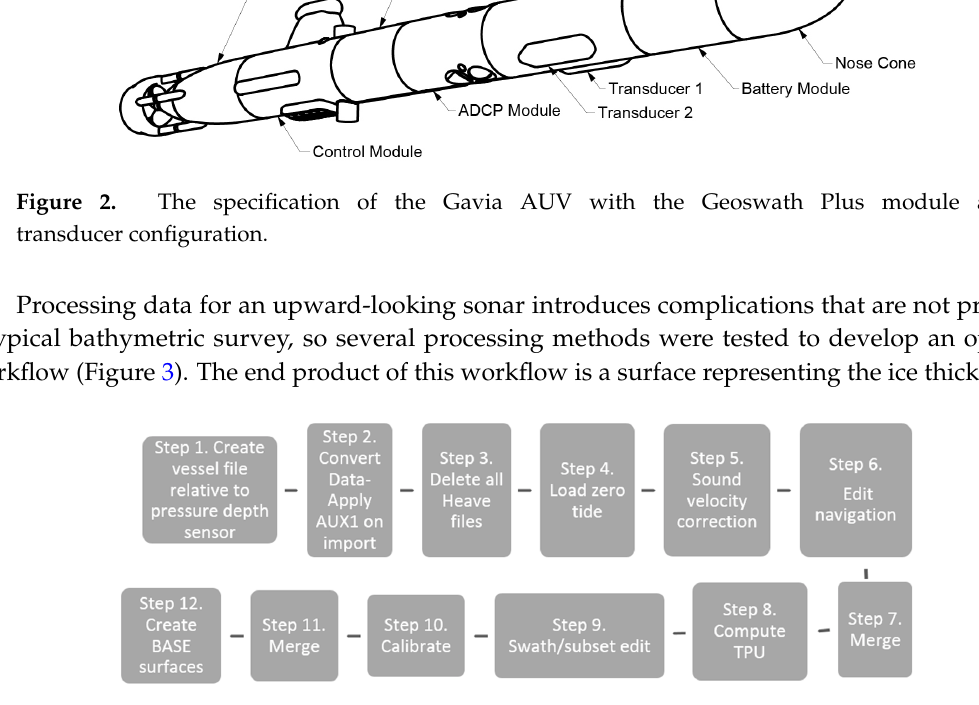
Figure 3. Processing workflow for under ice acoustic bathymetry processing. Step 2 AUX1 relates to the pressure based depth values.